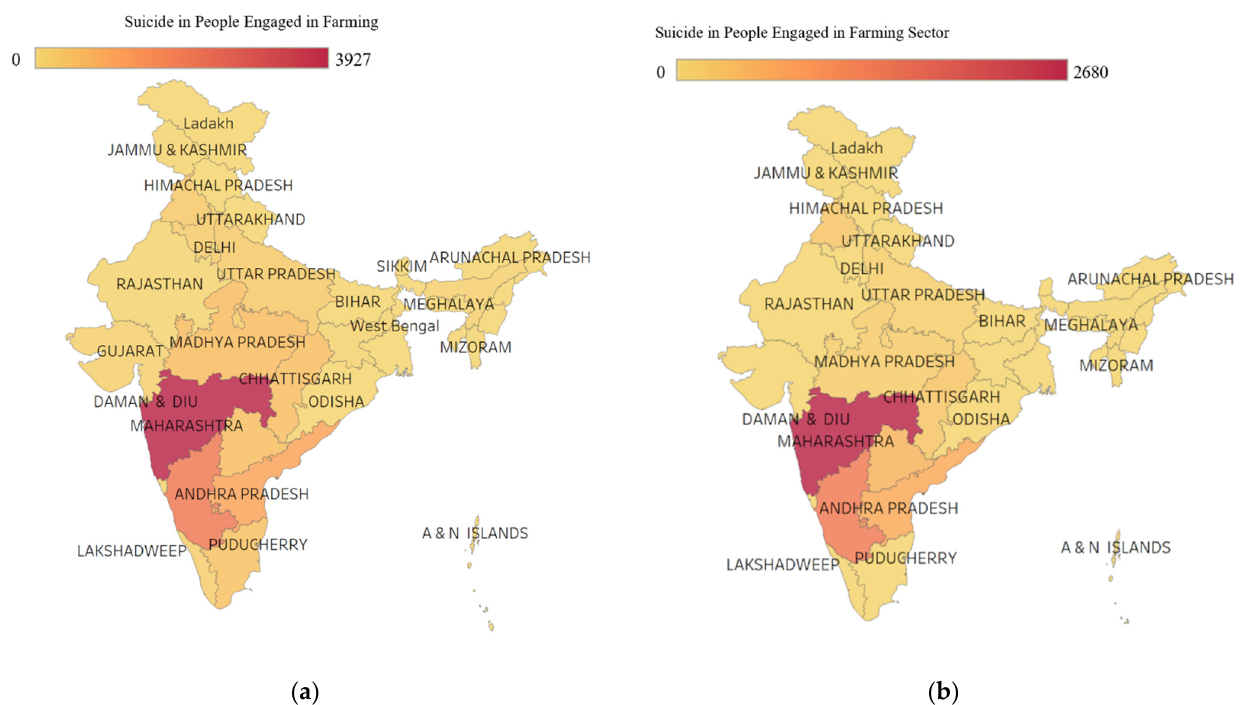
Figure 5. Number of suicides committed in the year 2019 as per NCRB by the ( a ) farmers, ( b ) persons engaged in farming related sectors.